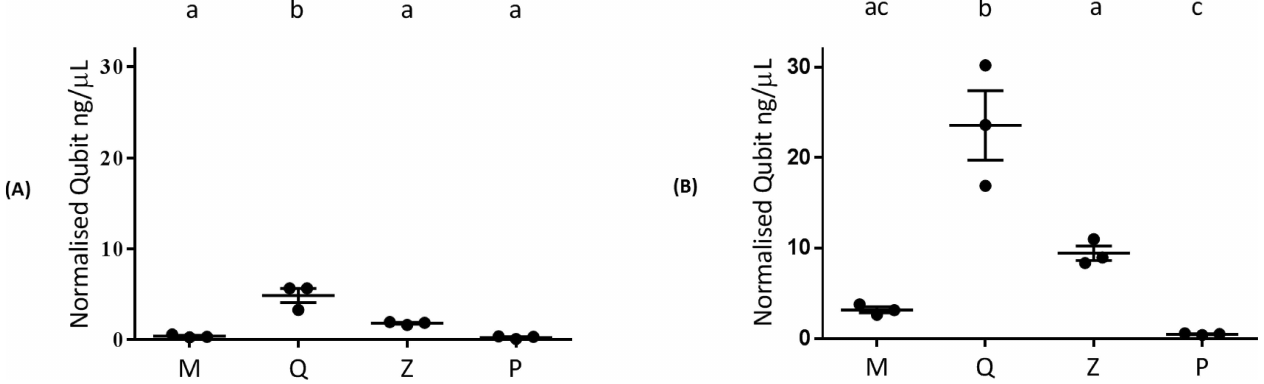
Fig 1. Normalised DNA yield (ng/ μ L) from (A) plaque and (B) saliva (mean ± SEM). M: MoBio PowerSoil ® DNA IsolationKit, Q: QIAamp ® DNA Mini Kit, Z: Zymo Bacterial/Fungal DNA Mini Prep TM , P: Phenol:chloroform-based DNA isolation. DNA extraction methodsnot linked by the same letter are significantly different to each other (Tukey-Kramer p (cid:20)